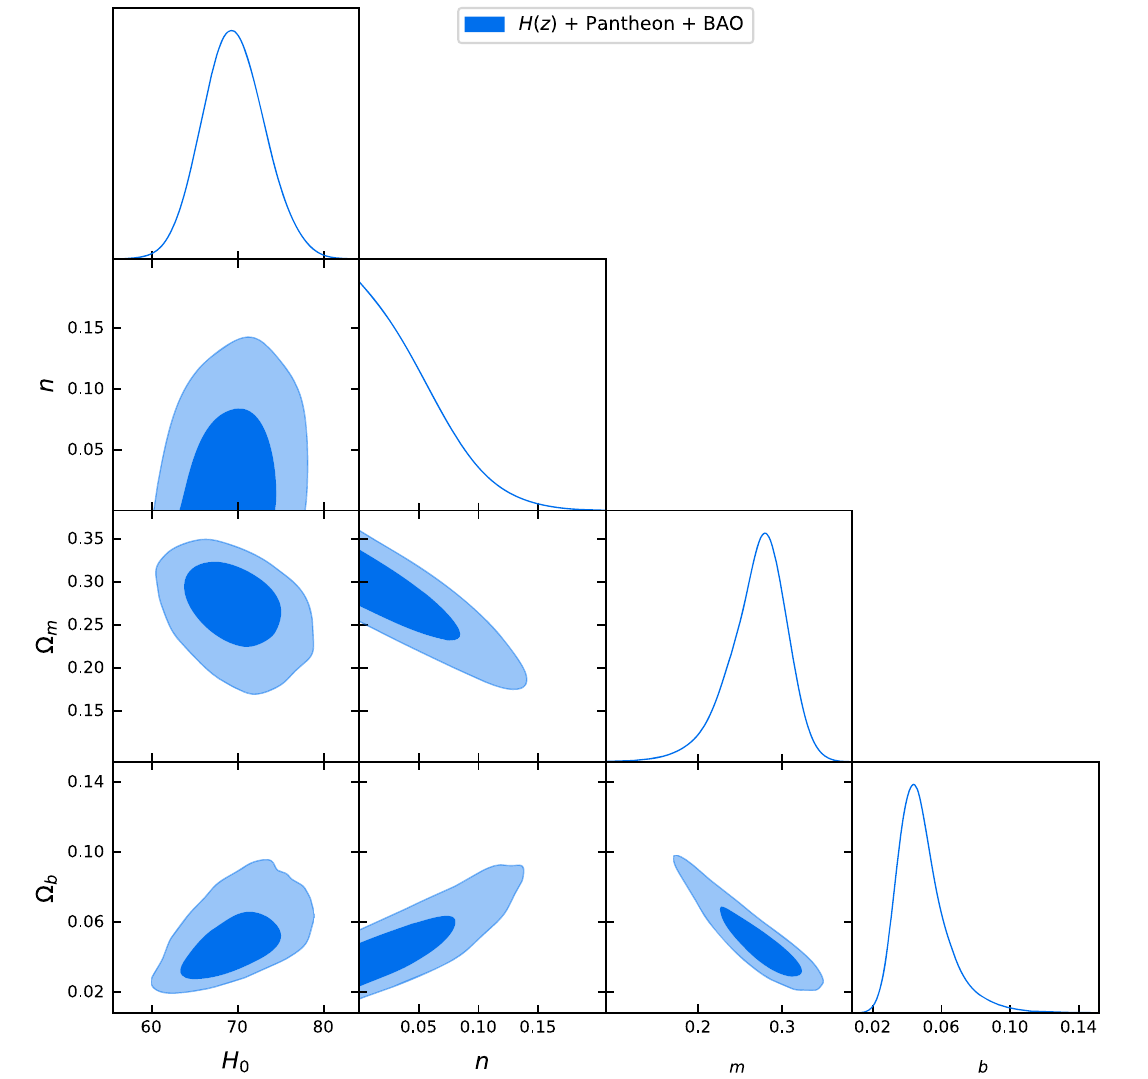
Fig. 2 Case I: Contours of the parameters H 0 , (cid:7) m , (cid:7) b and n at 1 σ and 2 σ c.l. for the joint analysis of H ( z ) + SNe Ia (Pantheon) + BAO, with the prior n ≥ 0